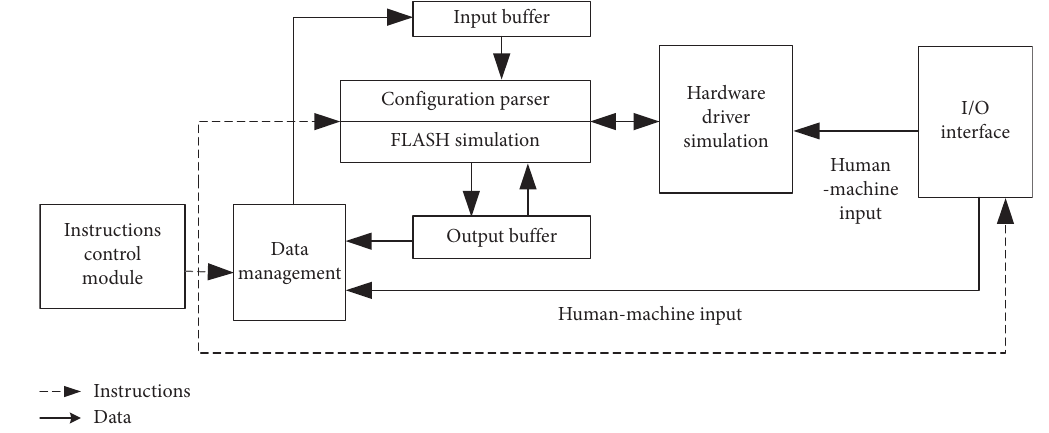
Figure 8: Overall architecture of the SVDU configuration